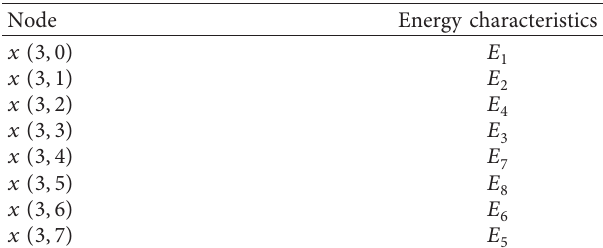
Figure 4: Three-layer decomposition tree structure of wavelet packet. Table 3: Correspondence between wavelet packet nodes and en- ergy